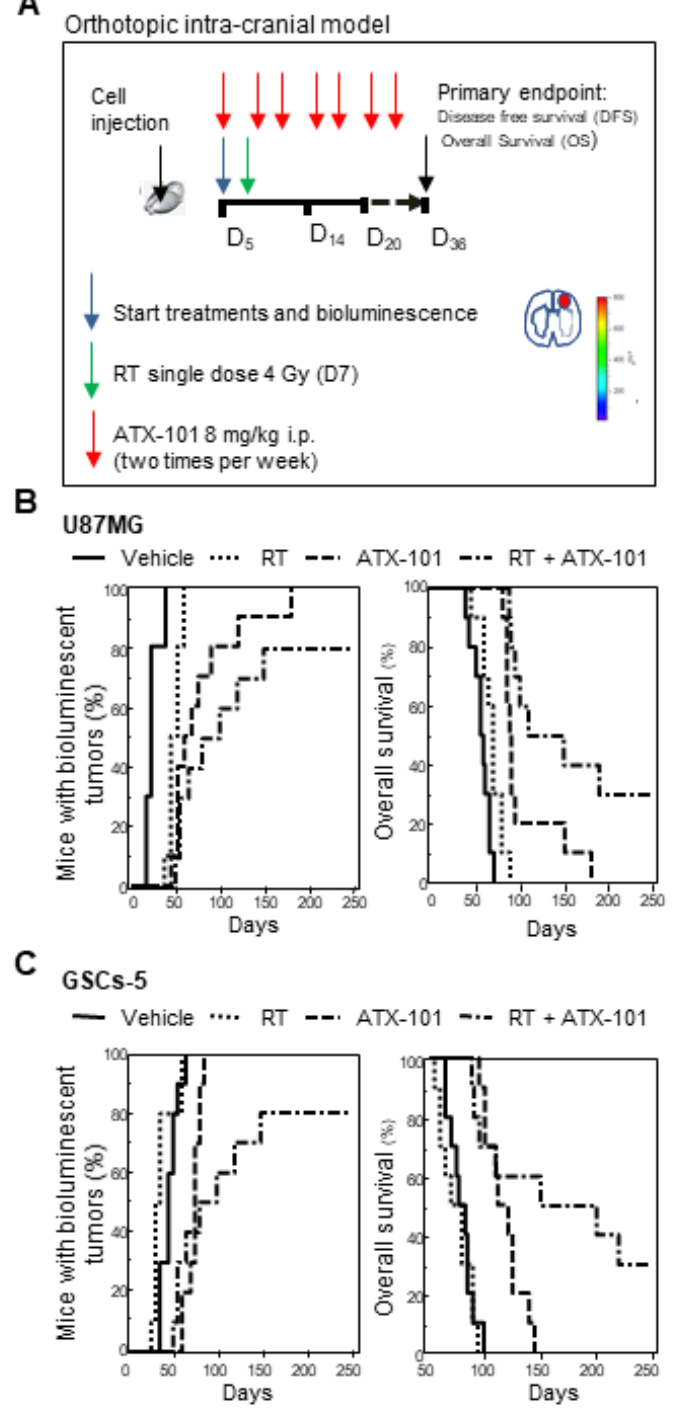
Figure 8. ATX-101 reduces the growth of intrabrain U87MG and GSCs-5 tumors. ( A ) Treatment scheme: 10 animals in each group received intrabrain injection of 1 × 10 3 luciferase-tagged U87MG or GSCs-5 cells. Vehicle or ATX-101 (8 mg/kg) were administered intraperitoneally (i.p.) two times per week (D5, D8, D12, D15, D19, D22, D26, D29, and D33); radiotherapy (RT) (4 Gy) was given as a single administration on D7. Primary endpoint was set at D36, but the mice were followed for up to 250 days. ( B , C ) Kaplan–Meier curves of percentage of mice with bioluminescent tumors, i.e., mice with progression, and overall survival, U87MG ( B ), and GSCs-5 ( C ). Statistics are shown in Tables S4 and S5.